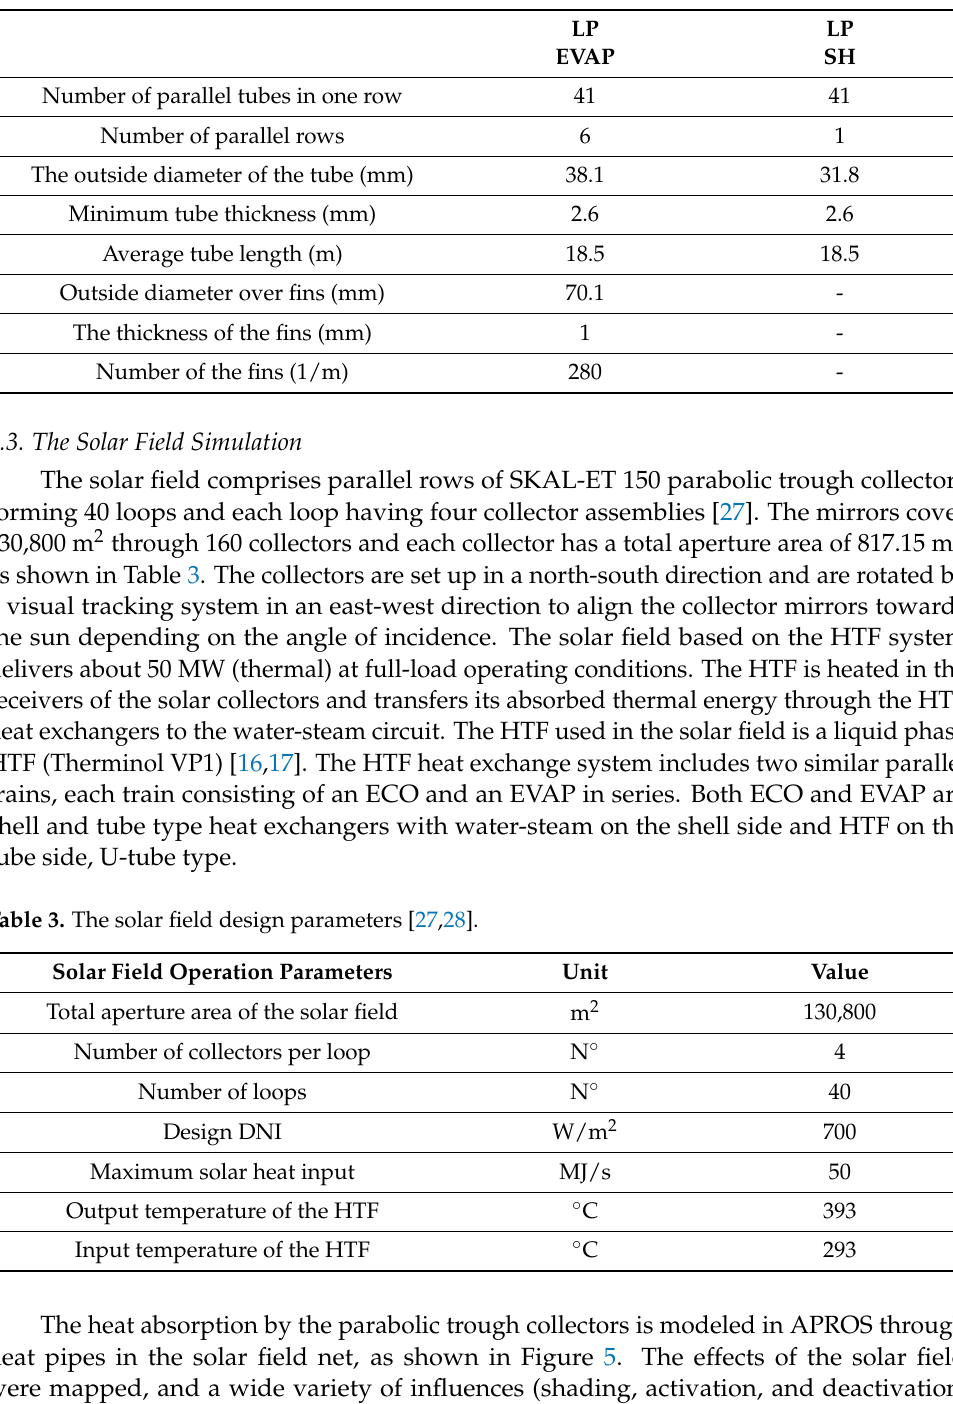
Table 2. Initialization of the HRSG low-pressure heating modules.